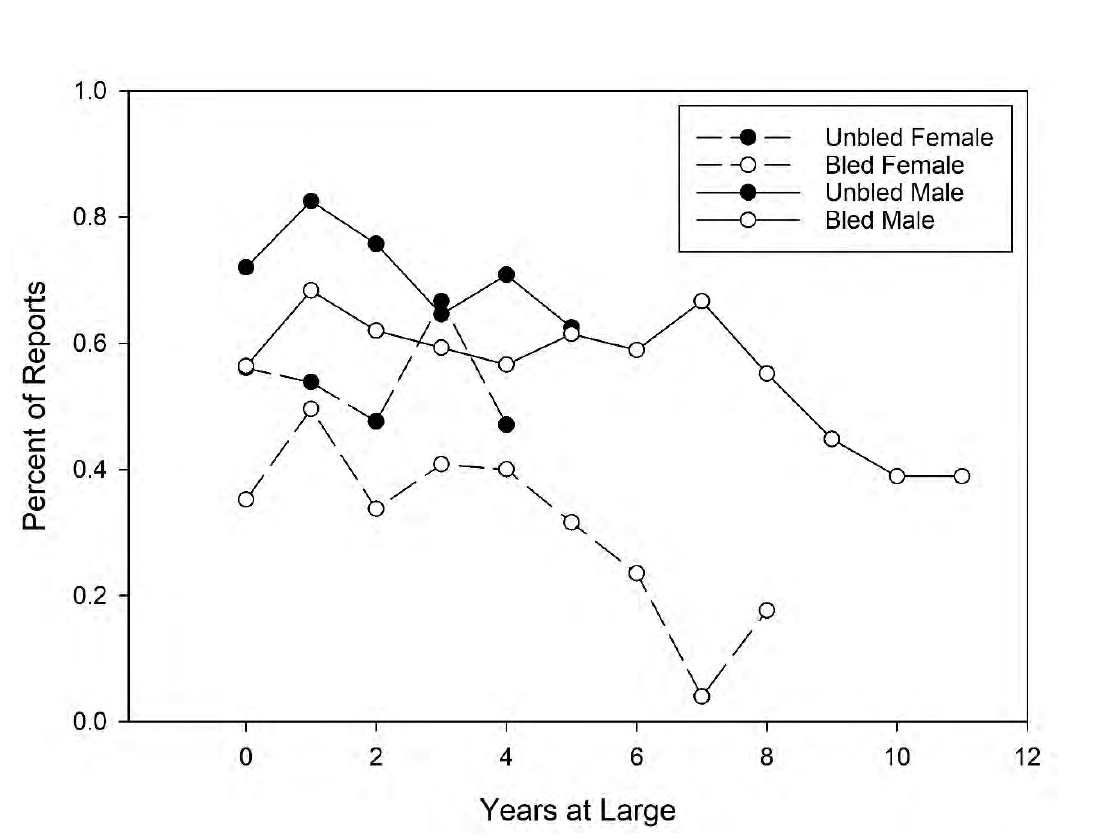
Figure 7. Comparison of bled (open circles) and unbled (filled circles) male (solid line) and female (dashed line) horseshoe crabs recaptured as alive over